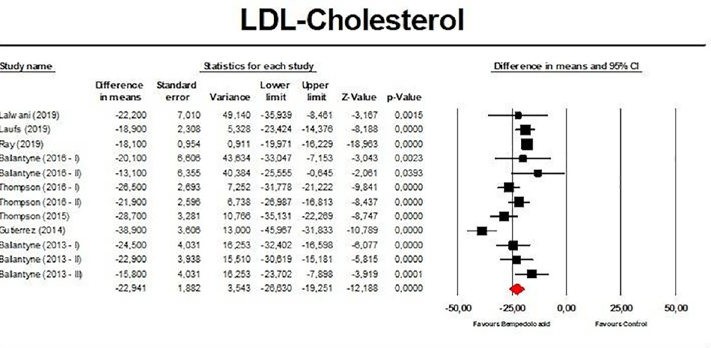
Fig 4. Forest plot displaying mean difference and 95% confidence intervals for the effect of bempedoic acid on plasma levels of low-density lipoprotein (LDL) cholesterol.